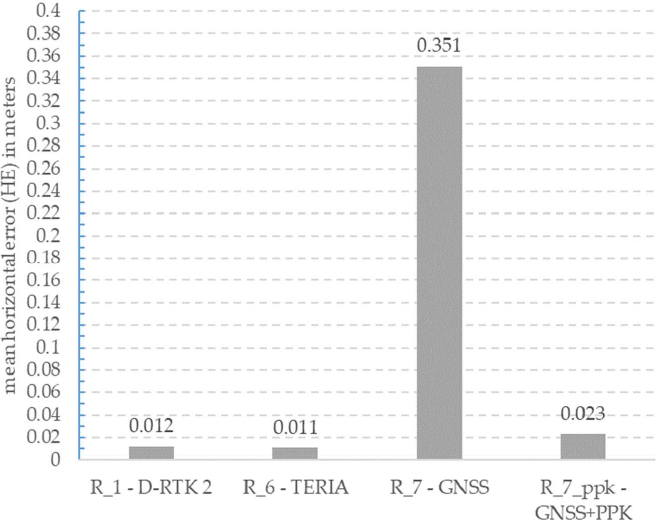
A comparison of the mean values of HE obtained with the different GNSS modes is presented in Figure 27. The accuracies obtained with the D-RTK2 base station and with the NRTK TERIA mode were almost identical, i.e., 1.1 and 1.2 cm, respectively.